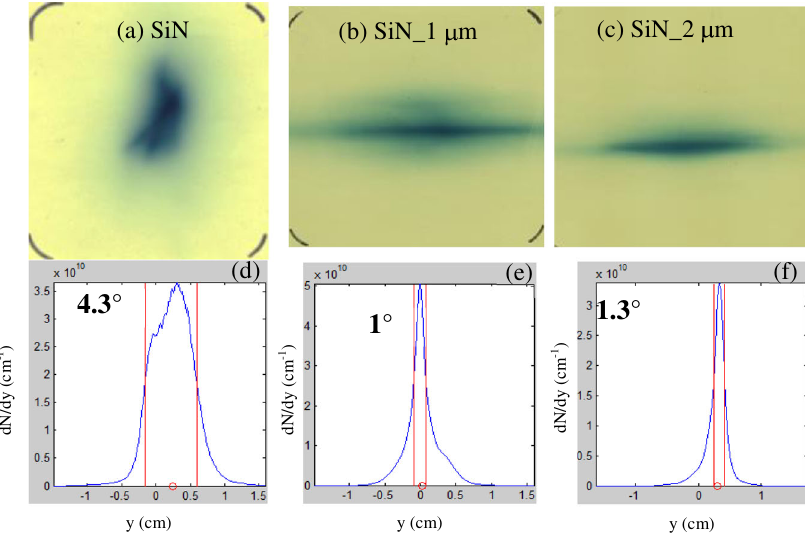
FIG. 5. Examples of radiochromic films showing the spatial profiles of proton beams emerging from SiN (obtained accumulating 2 shots) (a), from a SiN 1 μ (1 shot) (b) and from a SiN 2 μ (1 shot) (c) targets. (d),(e),(f) show the lateral profile of the proton beam for the m m different targets in (a) –